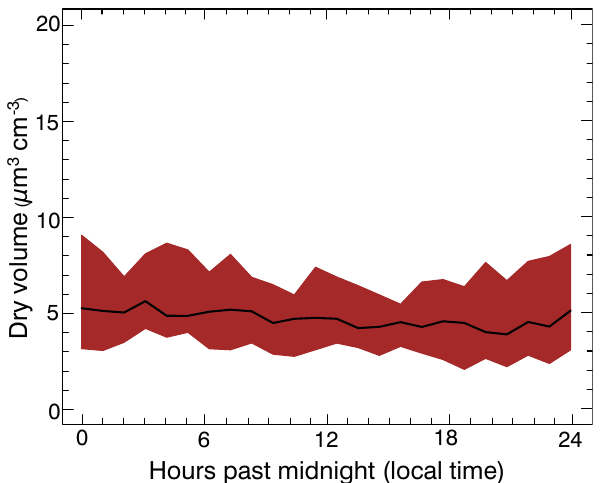
Figure 11. Diurnal trend of dry aerosol volumes binned into hourly intervals. The central black line shows the median of the measure- ments. The shaded red area indicates the interquartile range.